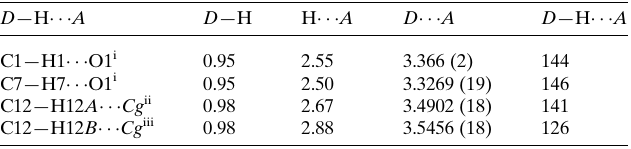
Table 1 Hydrogen-bond geometry (A˚ , (cid:3) ) for I . Cg is the centroid of the C1–C4/C8/C9 benzene ring. D —H (cid:2)(cid:2)(cid:2) A